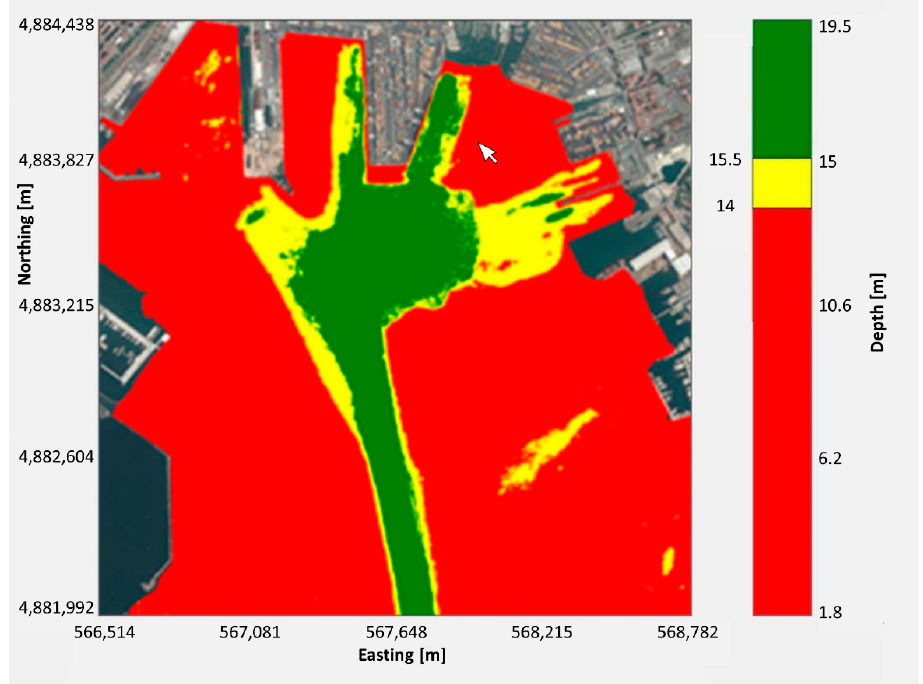
Figure 10. Virtual traffic lights in the port of La Spezia on 24 November 2010 at 18:00 UTC (threshold levels 14 and 15.5 m).